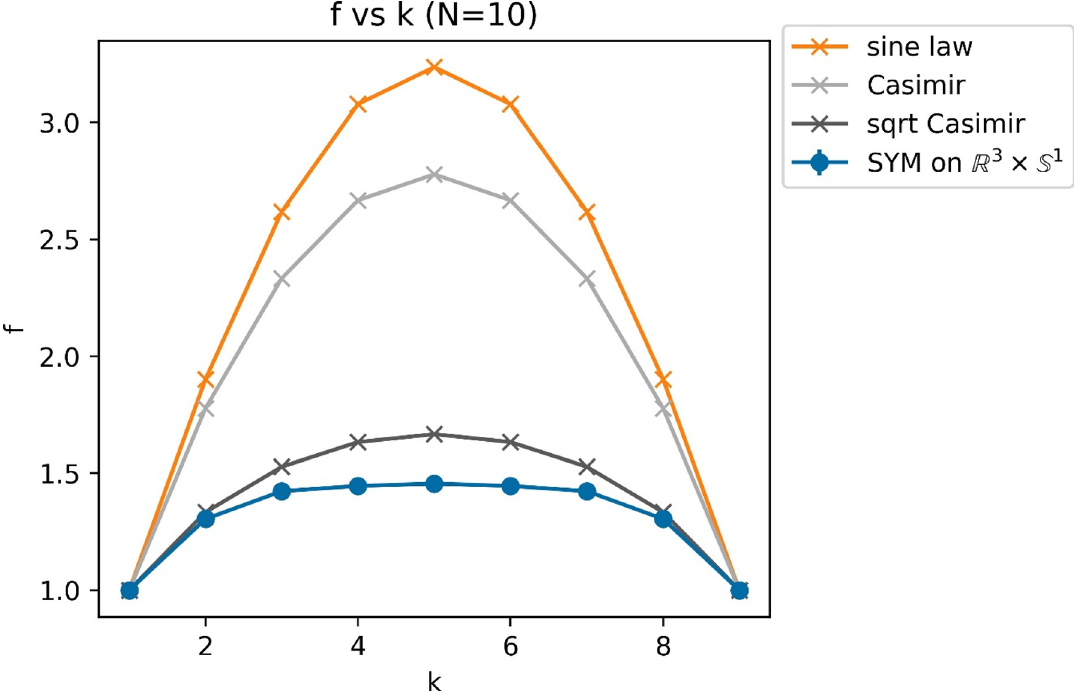
Figure 1. The dependence of the k -string tension ratio f = T ( k,N ) on k for SU(10) , compared T (1 ,N ) with other known scaling laws. Here, T ( k, N ) denotes the tension of the stable k -string for SU( N ) . Recall that the sine law approximately holds in softly-broken Seiberg-Witten theory and the MQCD embedding of SYM. The square-root law was found in the MIT Bag Model, as well as, approximately, in deformed Yang-Mills theory on R 3 × S 1 . Our results show that the N -ality dependence of f in SYM on R 3 × S 1 at small L is flatter than any of the other known scaling laws. A qualitative explanation follows from the BPS DW properties and is given in the text. The flat N -ality dependence shows that in the abelian large- N limit, confining strings remain